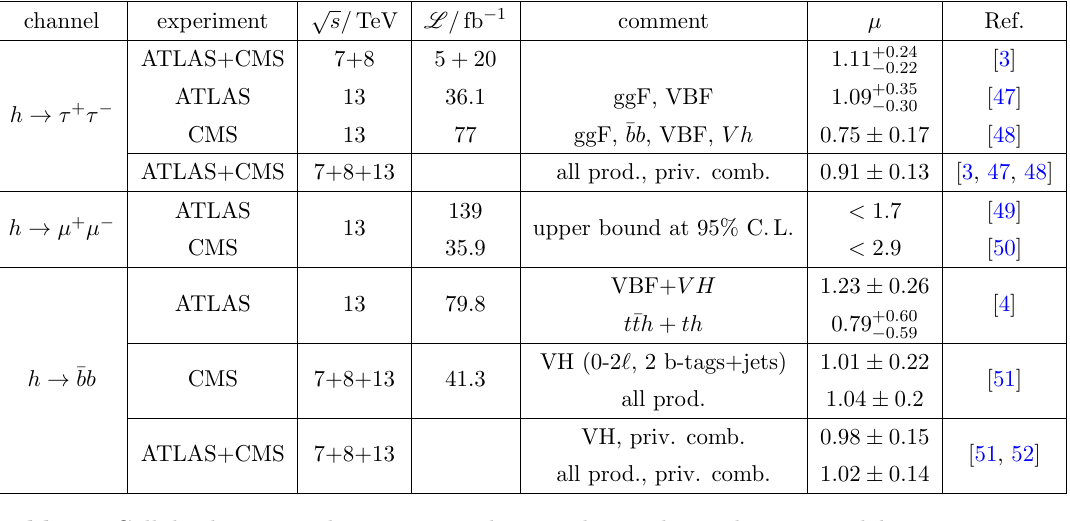
Table 2 . Collider limits on the Higgs signal strengths involving the (cid:28) , (cid:22) and b . In our private combinations, the uncertainties are approximated as